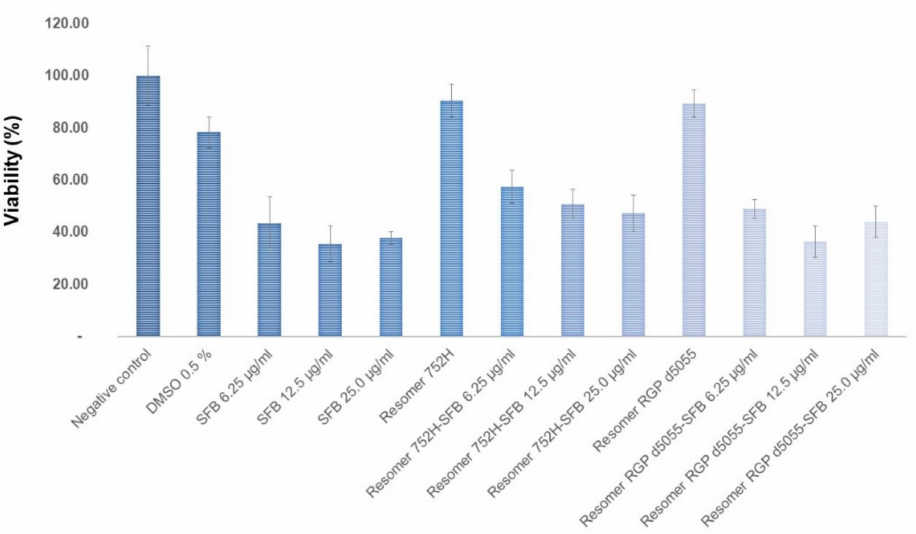
Figure 10. Viability of HepG2 cells treated with di ff erent concentrations of sorafenib (SFB) or Resomer ®